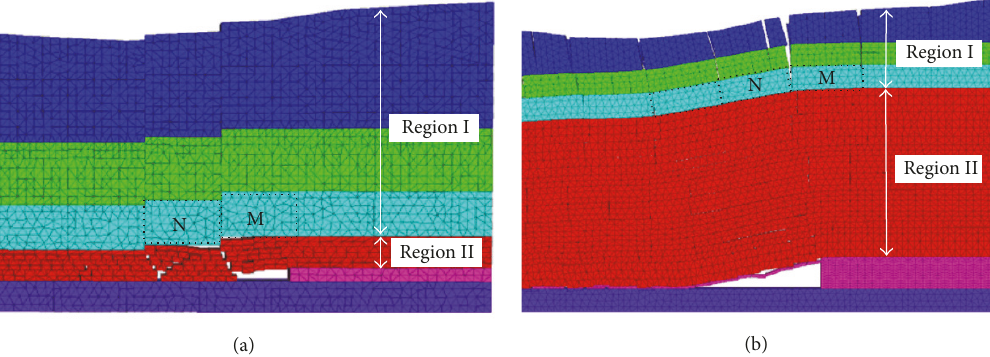
Figure 9: Movement form of the loading key strata and the overlying strata under supercritical extraction of Working face 4104 and Working face 6104.